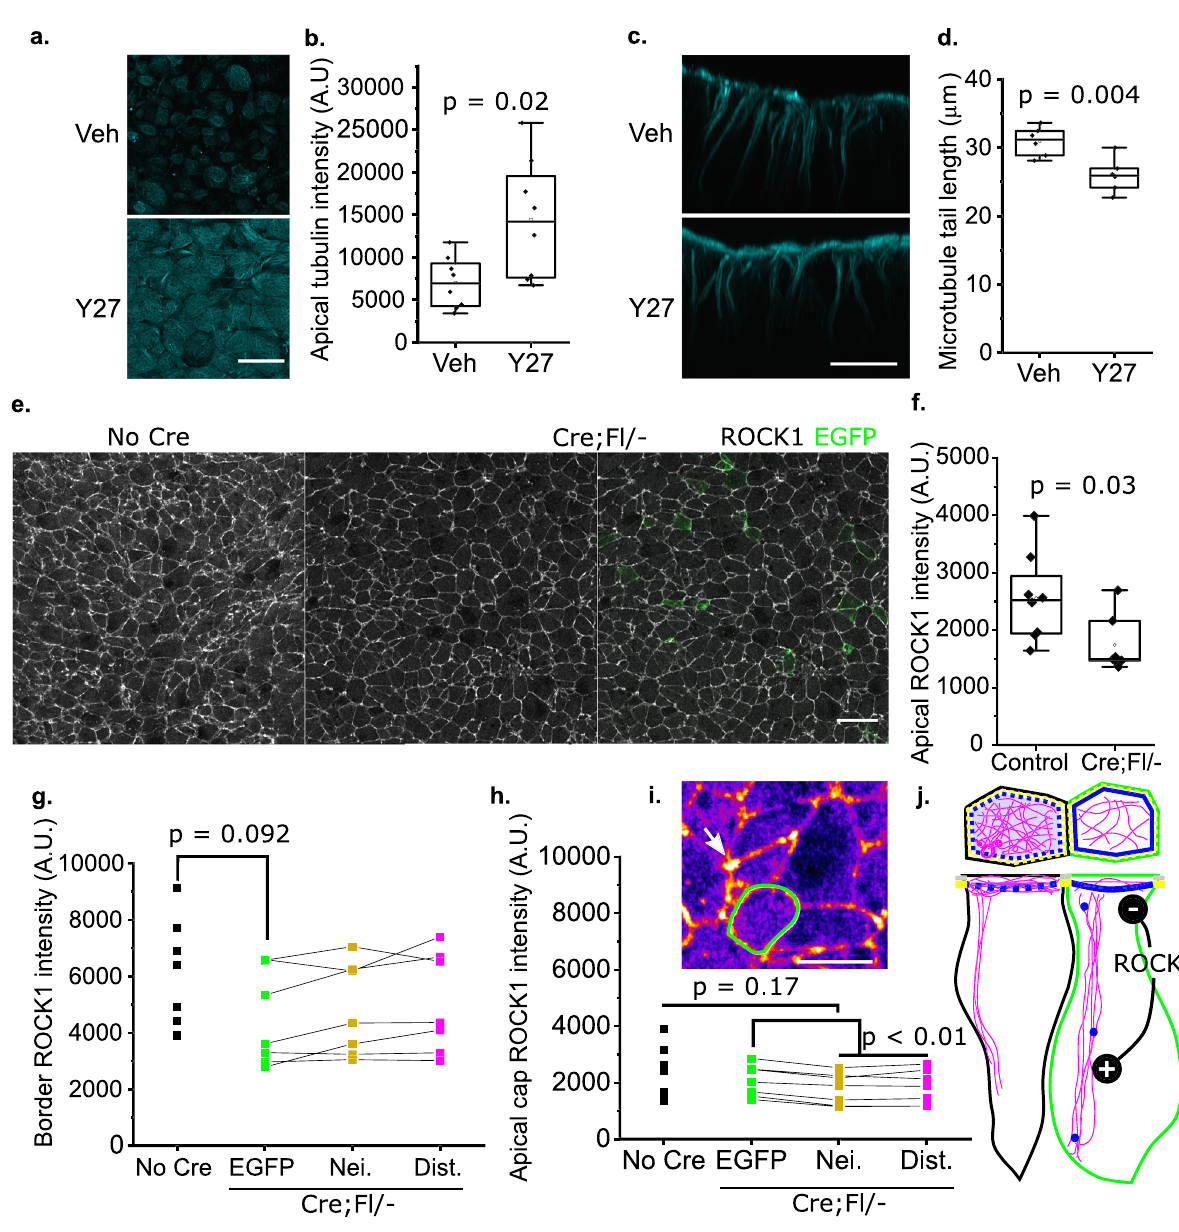
autonomous control of apical constriction described here.